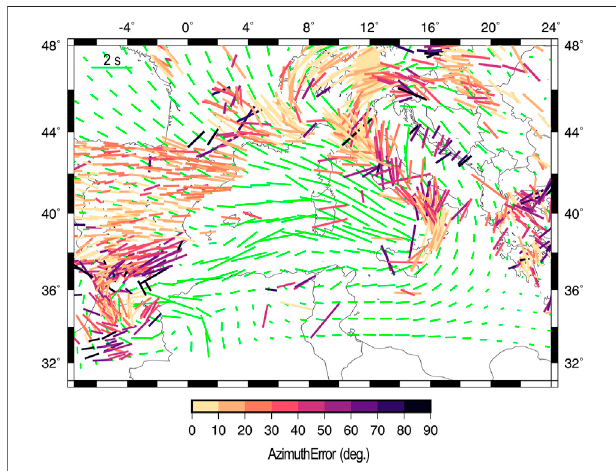
FIGURE 7 | SKS-splitting measurements in the Central-Western Mediterranean (Becker et al., 2012) color-coded by the angular mis fi t compared with synthetic SKS splitting measurements for Model CWM at ~20 Myr(greenbars).TheEWgreenbarintheupperleftcornerindicates 2 s. Time-delay mis fi ts are shown in Supplementary Figure S5A